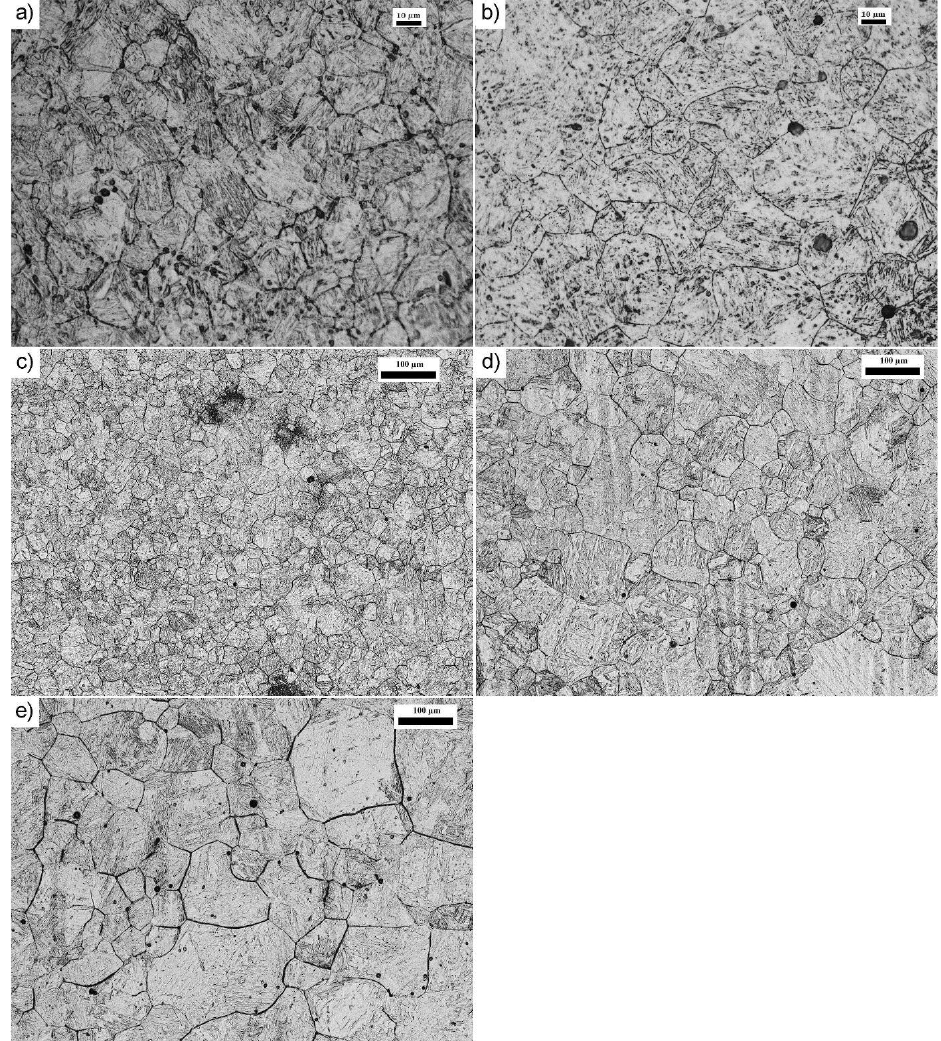
Figure 4. Micrographs of austenite grain boundaries in the as-received state and under different annealing conditions: ( a ) in the as-received state; ( b ) 900 °C, 20 min; ( c ) 1000 °C, 20 min; ( d ) 1100 °C, 20 min; ( e ) 1200 °C, 20 min. Etched state, light microscope.